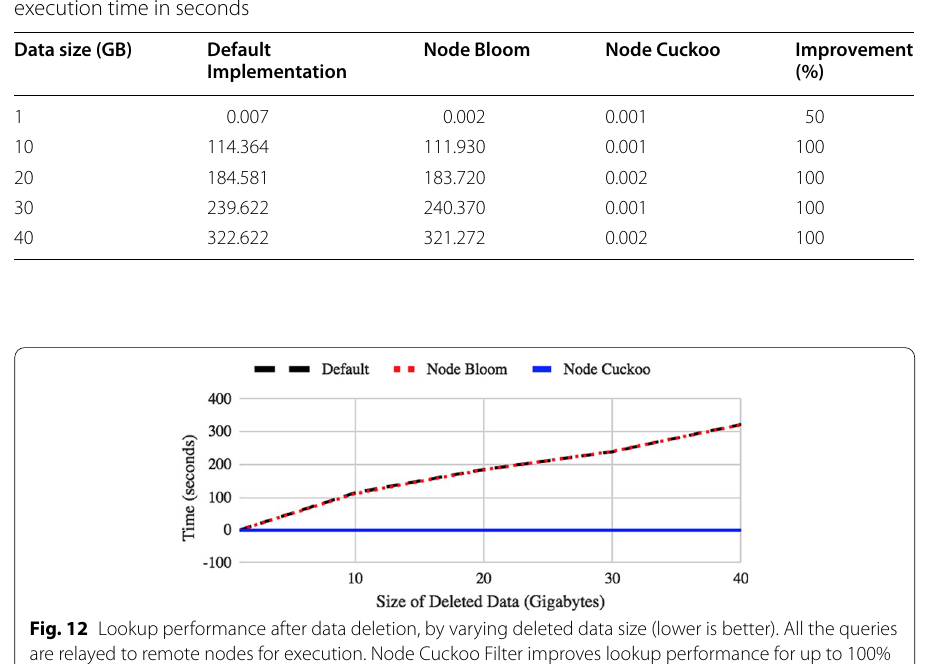
Table 8 Experimental Results 2: lookup performance after data deletion by varying data size.